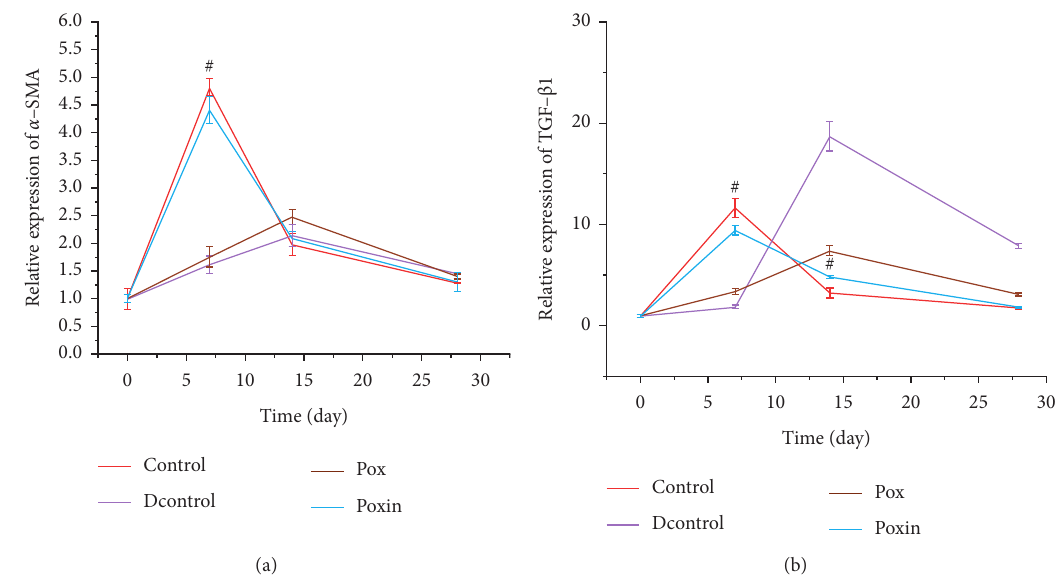
Figure 7: qRT-PCR quantification of the mRNA expression of α -SMA (a) and TGF- β 1 (b) at different time points (days 7, 14, and 28) after wounding. Data were standardized by the expression level of GAPDH in each sample and presented as the relative expression of those from each group. ∗ P < 0 . 05, the Poxin group vs. the Control group. # P < 0.05, the Poxin group vs. the DControl